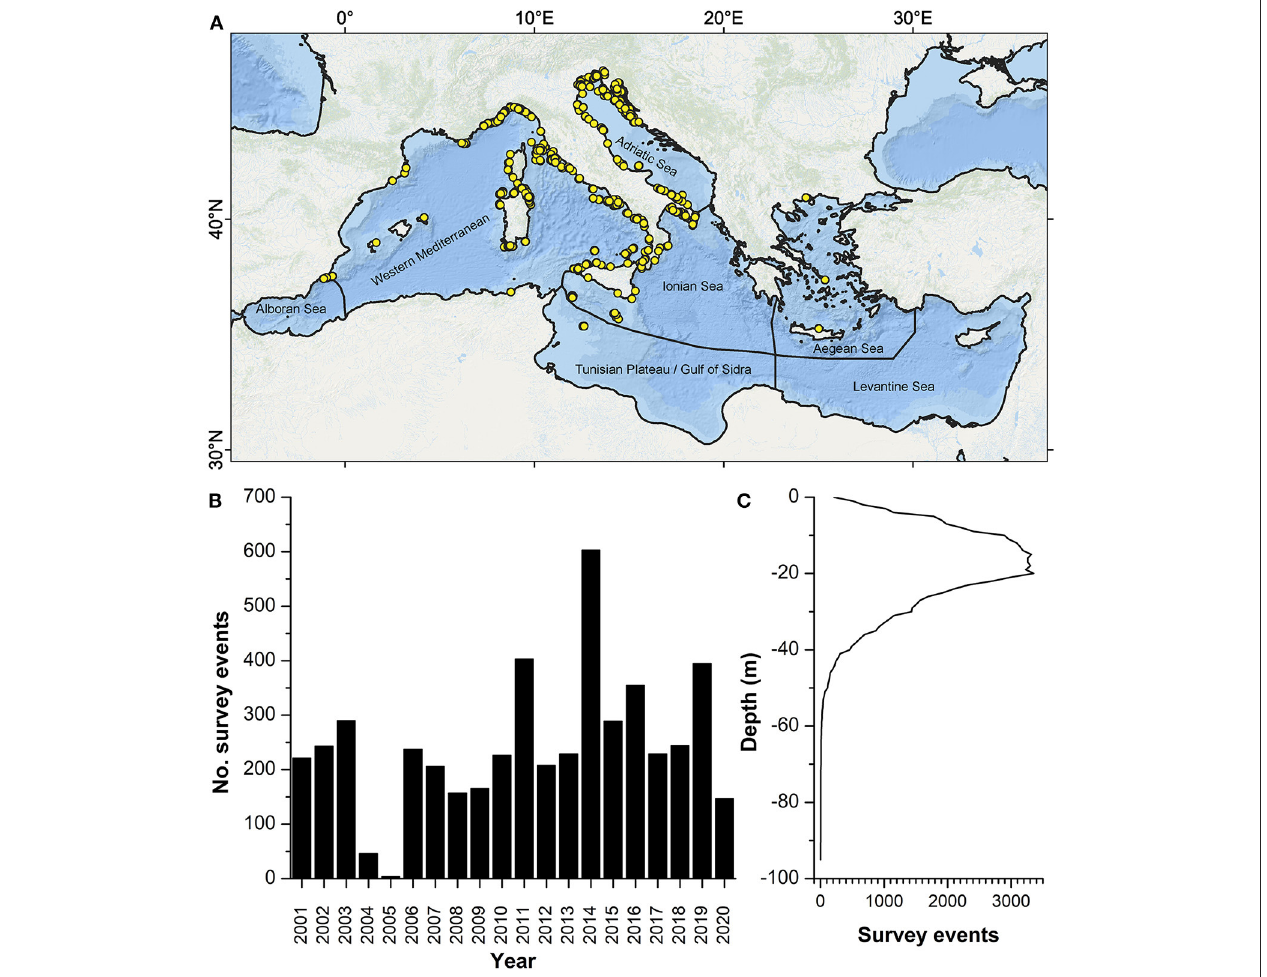
FIGURE 1 | Summary of the survey events included in the RCMed_2001–2020 dataset: (A) geographic distribution of all recorded survey events (yellow dots) within the Mediterranean ecoregions, defined according to Spalding et al. (2007) (Mercator projection); (B) temporal distribution; (C) depth distribution.